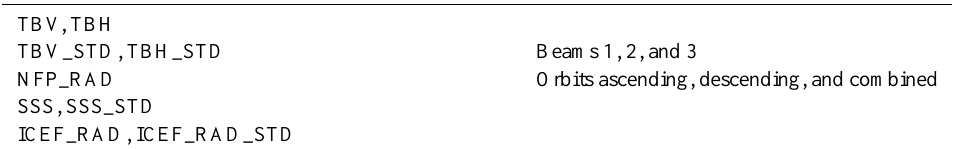
Table 3. Product names with the list of variables per beams and orbits. Acronyms are TB – brightness temperature; V – vertical polarization; H – horizontal polarization; STD – standard deviation; NFP – number of footprint observations; RAD – radiometer; SCA – scatterometer; SSS – sea surface salinity; ICEF – sea ice fraction; NRCS – normalized radar cross section; and SSS3b – sea surface salinity obtained by combining the three